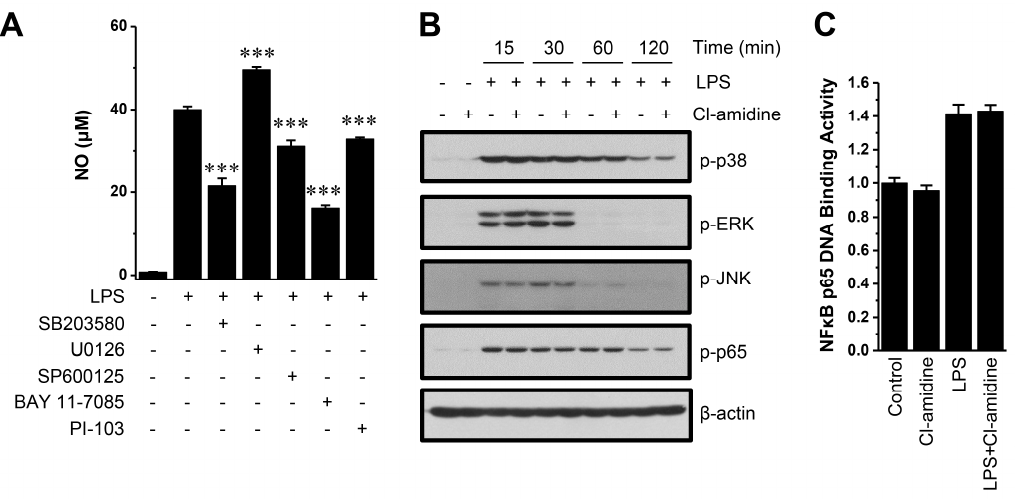
Figure 4. Cont. Figure 4.